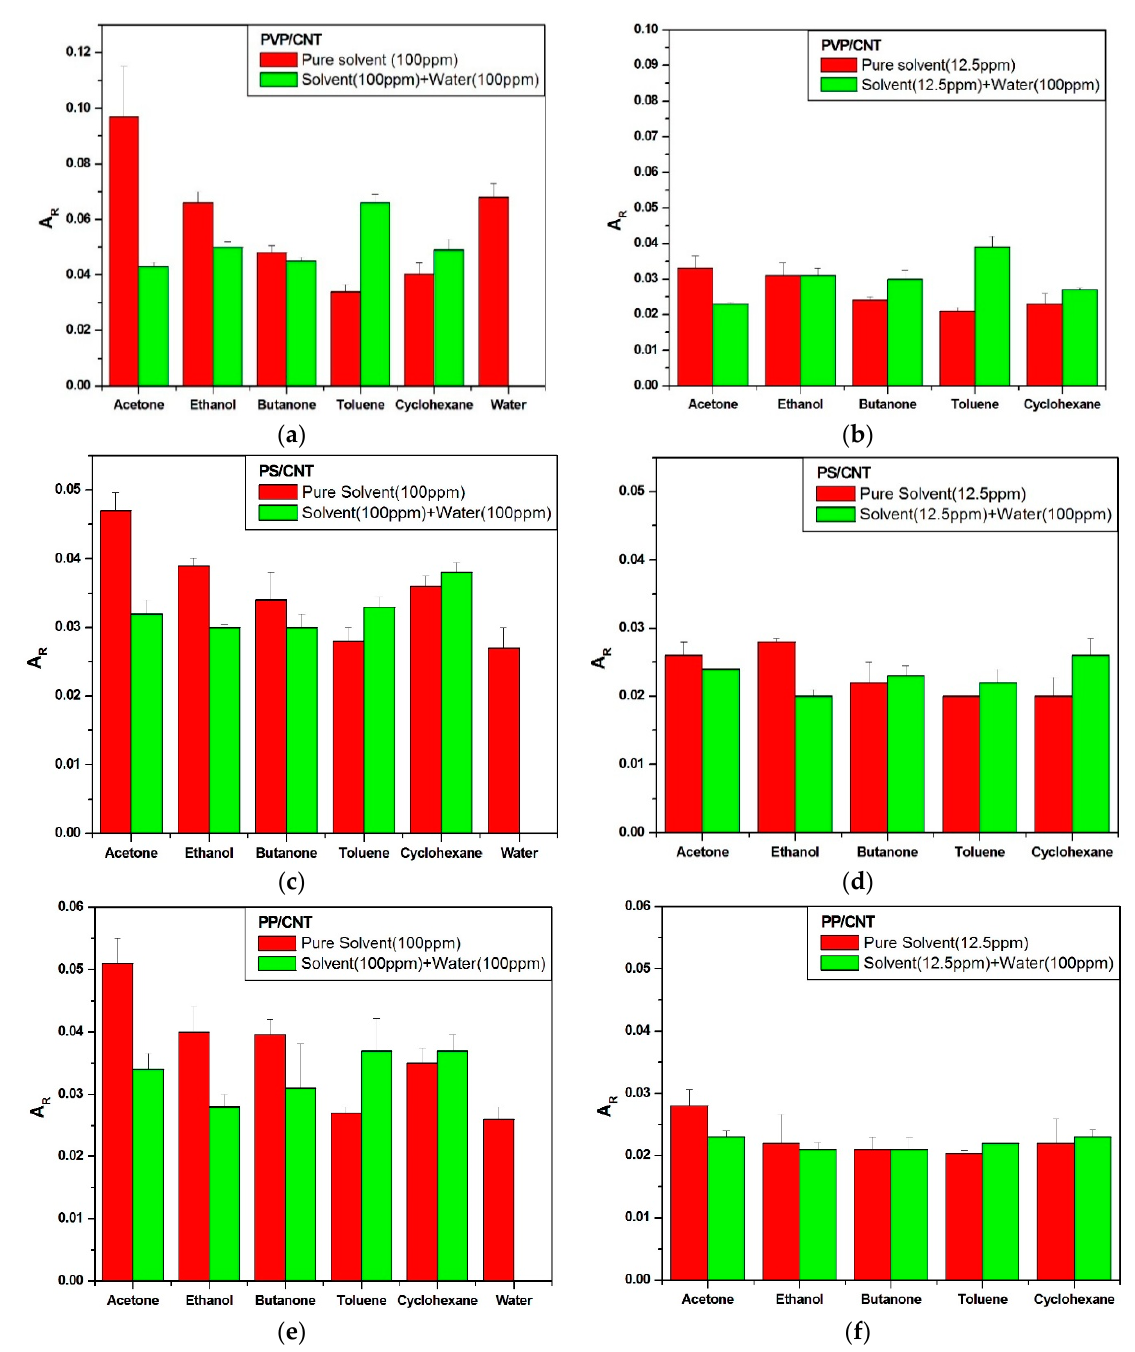
Figure 8. Maximum amplitudes of the chemo-resistive responses A r of vQRS exposed to five different VOC mixed with 100 ppm water, ( a ) PVP-CNT @100 ppm, ( b ) PVP-CNT @12.5 ppm, ( c ) aPS-CNT @100 ppm, ( d ) aPS-CNT @12.5 ppm, ( e ) aPP-CNT @100 ppm, and ( f ) aPP-CNT @12.5 ppm.